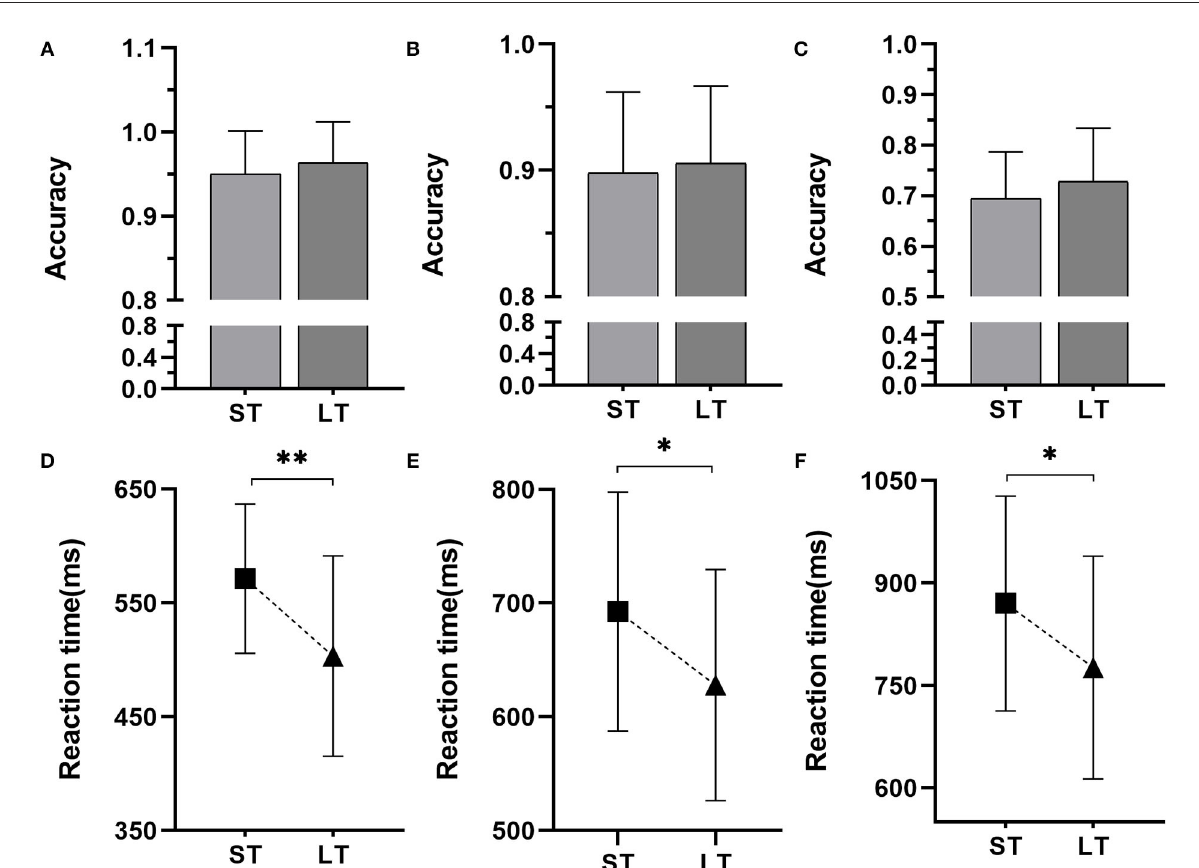
FIGURE2 Results of the N-back task. (A) The accuracy of the 0-back test, (B) the accuracy of the 1-back test, (C) the accuracy of the 2-back test, (D) the reaction time of the 0-back test, (E) the reaction time of the 1-back test, and (F) the reaction time of the 2-back test. ST, the short-term group; LT, the long-term group. * Statistically significant with P < 0.05, ** statistically significant with P <